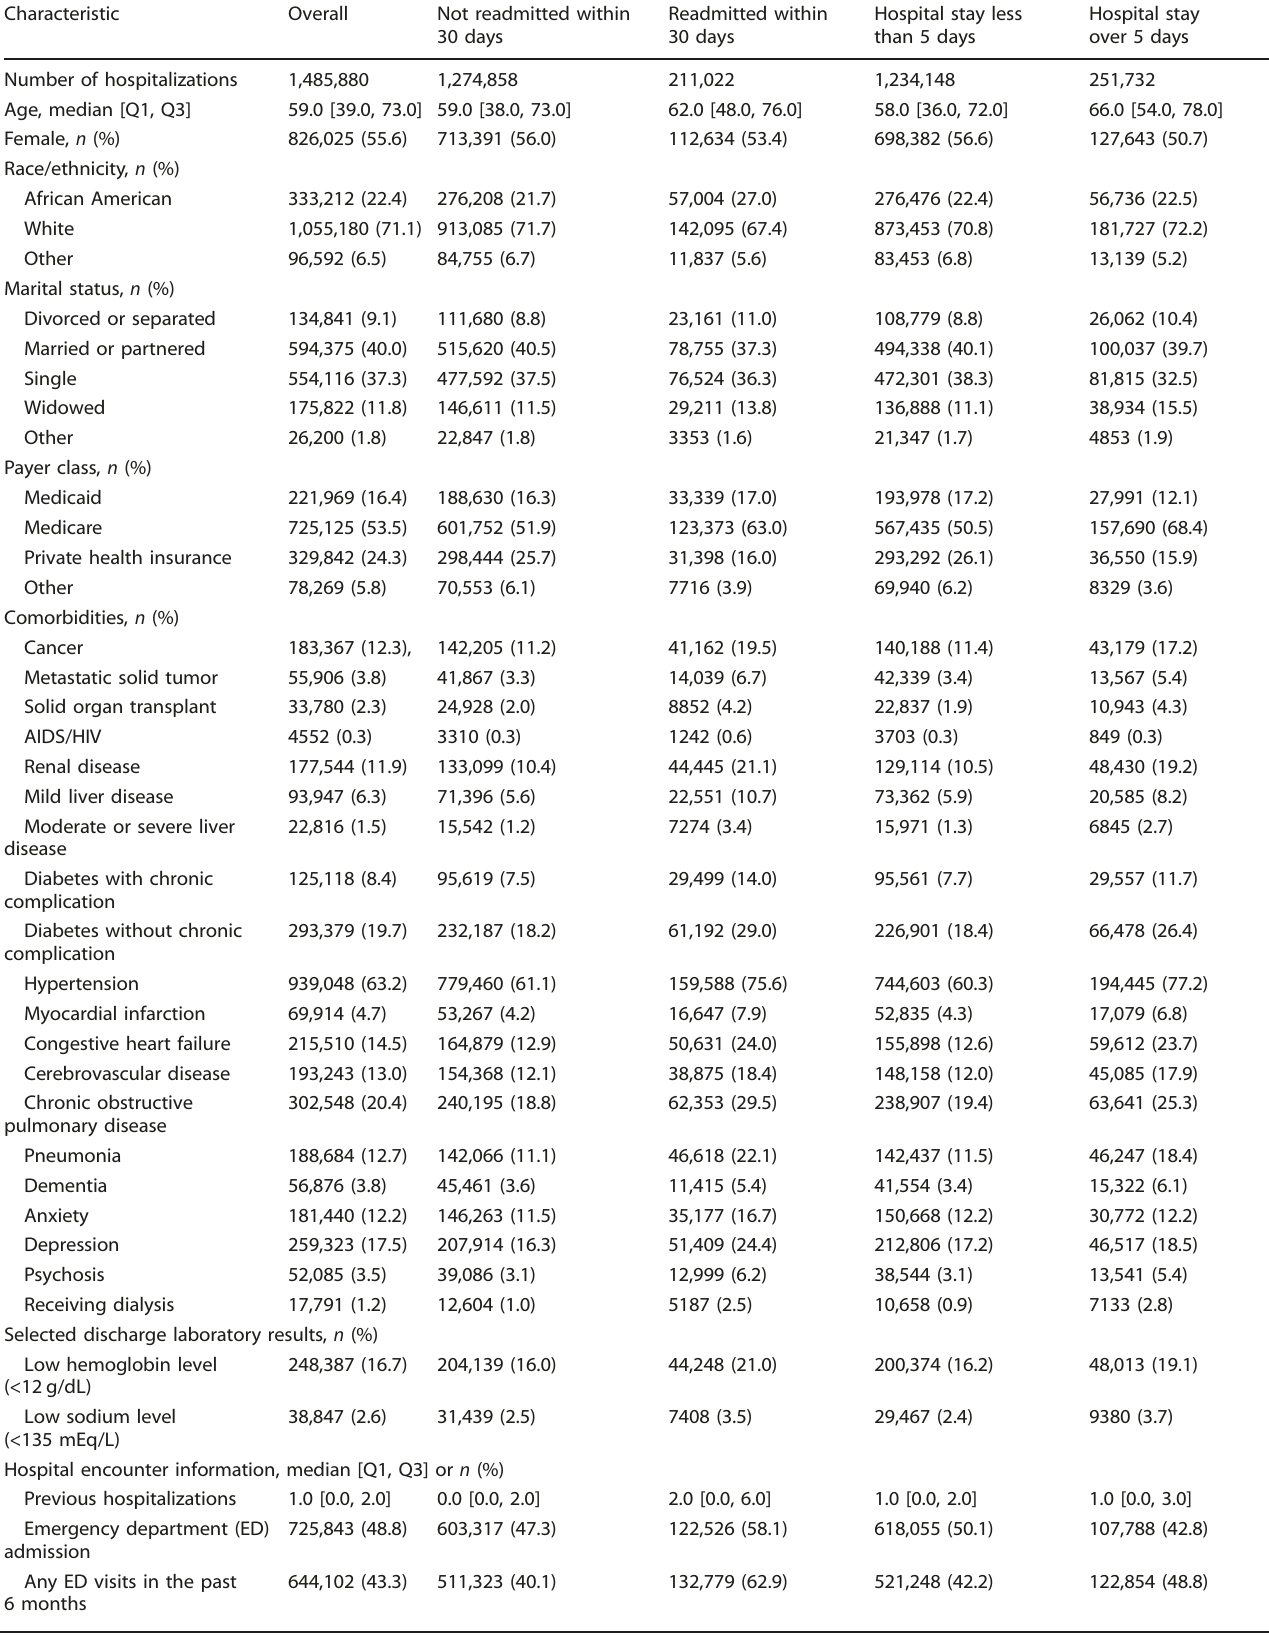
Table 1. Characteristics of hospital encounters in the study sample, overall and according to readmission and extended length of stay.